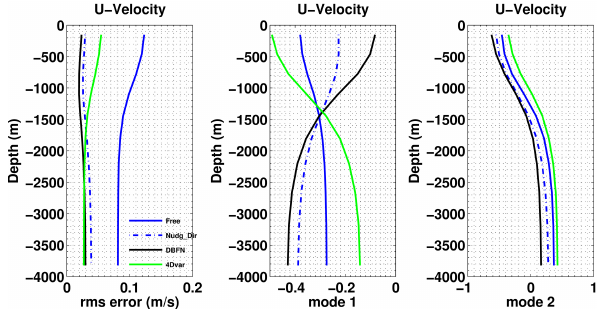
Figure 8. Vertical profiles of rms error in zonal velocity (left panel) and first (middle panel) and second (right panel) eof error modes calculated using a forecast from day 200 to day